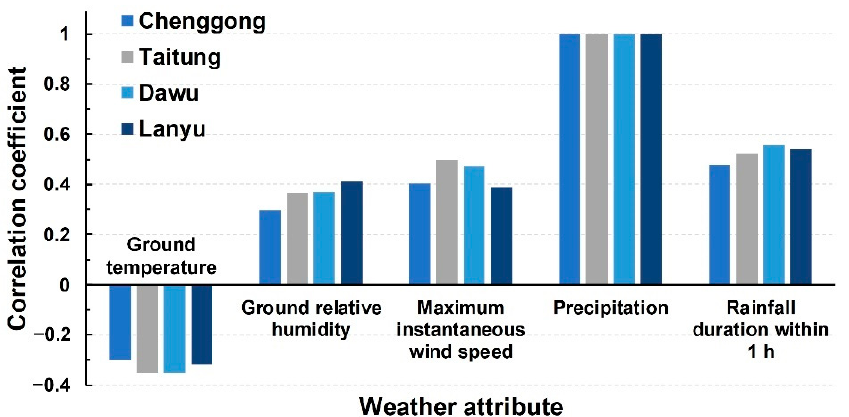
Figure 3. Correlation coefficients of ground-weather and precipitation characteristics at four stations.